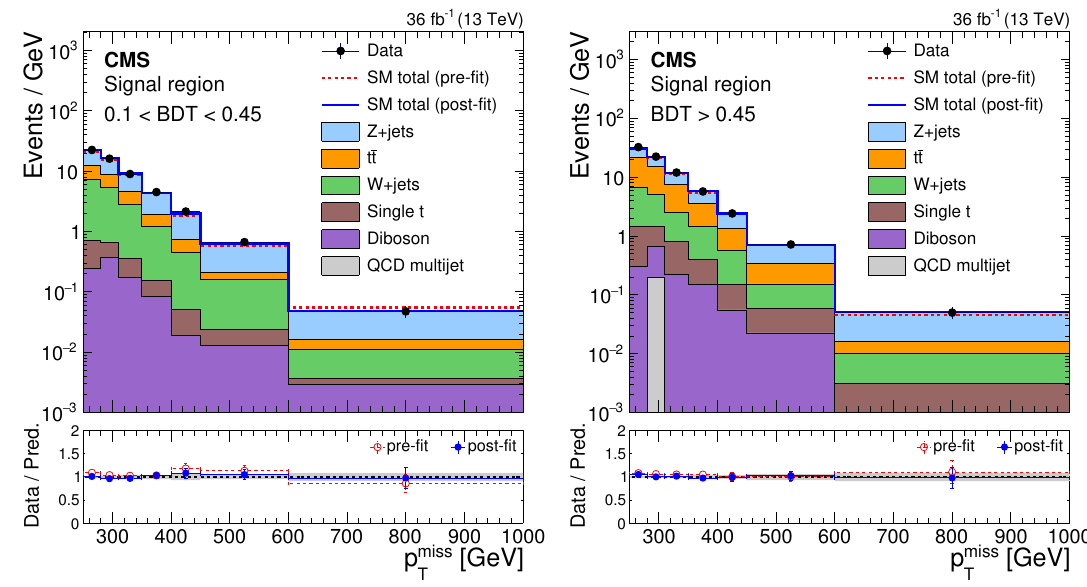
Figure 8 . Distribution of p miss from SM backgrounds and data in the signal region after simulta- T neously (cid:12)tting the signal region and all control regions. Each bin shows the event yields divided by the width of the bin. The left (right) (cid:12)gure corresponds to the loose (tight) category of the signal region. The stacked histograms show the individual (cid:12)tted SM background contributions. The blue solid line represents the sum of the SM background contributions normalized to their (cid:12)tted yields. The red dashed line represents the sum of the SM background contributions normalized to the pre- diction. The lower panel of each (cid:12)gure shows the ratio of data to (cid:12)tted prediction. The gray band on the ratio indicates the one standard deviation uncertainty on the prediction after propagating all the systematic uncertainties and their correlations in the